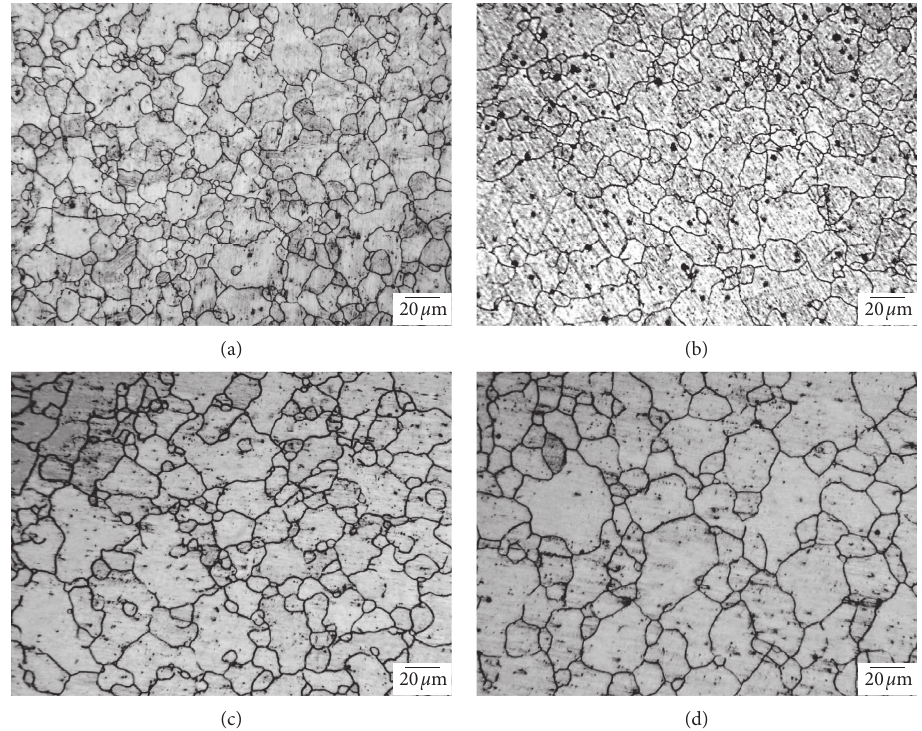
Figure 10: The metallographic structure of the cross section at different temperatures. (a) Original grain structure before solution treatment. (b) After holding at 300 ° C for 12 h. (c) After holding at 380 ° C for 12 h. (d) After holding at 420 ° C for 12 h.